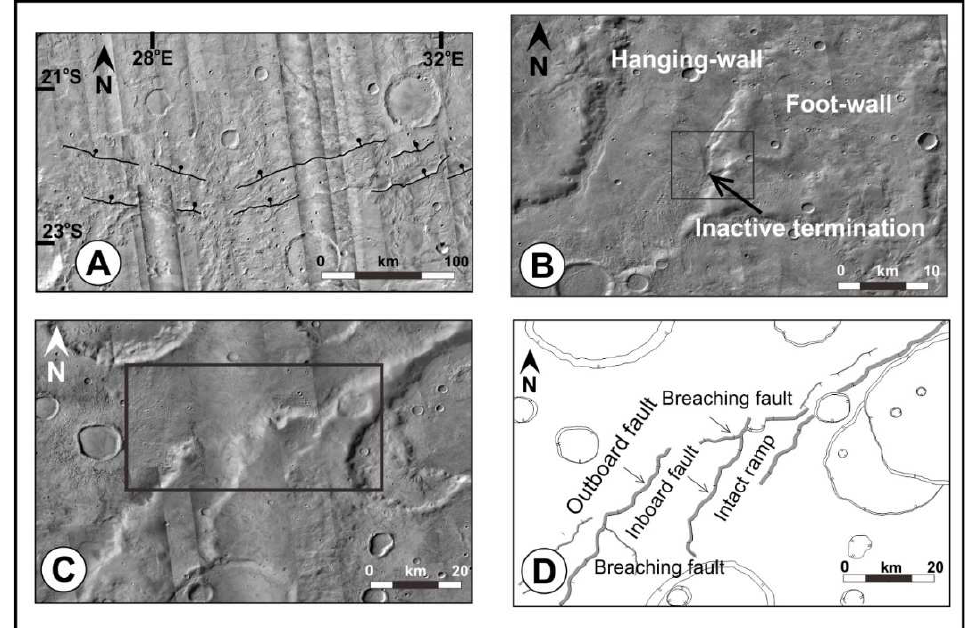
Figure 5. ( A ) A magnified region showing collateral synthetic half grabens with half-moon-shaped geometry. Balls indicate downdip direction. ( B ) Relay ramps associated with the graben. ( C ) Relay structures associated with a half-graben. Several morphometric terminologies associated with the relay ramps are shown in ( D ).